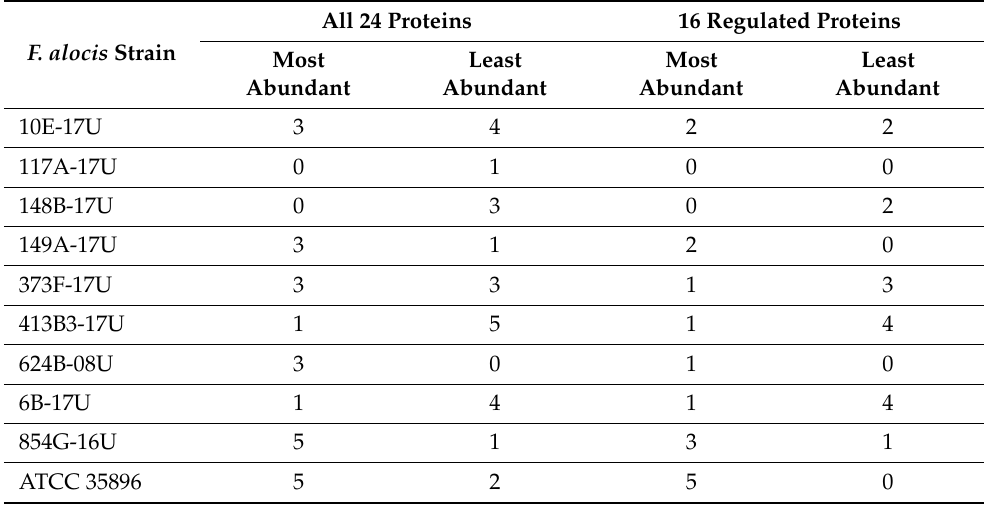
Table 2. EV protein abundancies in the ten F. alocis strains. The numbers of most or least abundant EV proteins in each F. alocis strain, as determined by label-free quantification proteomics, are indicated. All 24 Proteins 16 Regulated Proteins F. alocis Strain Most Least Most Least Abundant Abundant Abundant